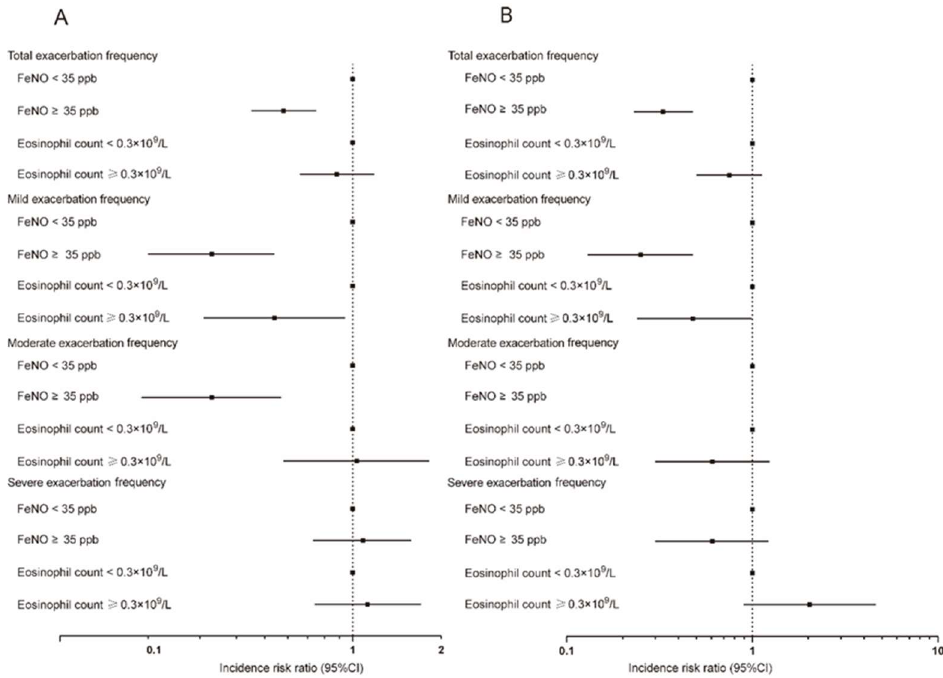
Figure 3. Separate association of increased FeNO level and blood eosinophil count with frequency of various degrees of acute exacerbation of COPD: ( A ) Smoking status adjusted; ( B ) multivariable adjusted. Poisson regression models were used. Multivariable adjustment included age, gender, BMI, smoking status, FEV 1 post-BD% pred, SGRQ, and 6-minute walking distance. FeNO, exhaled nitric oxide fraction; BMI, body mass index; FEV 1 , forced expiratory volume in 1 s; BD, bronchodilator; SGRQ, St. George’s Respiratory Questionnaire.